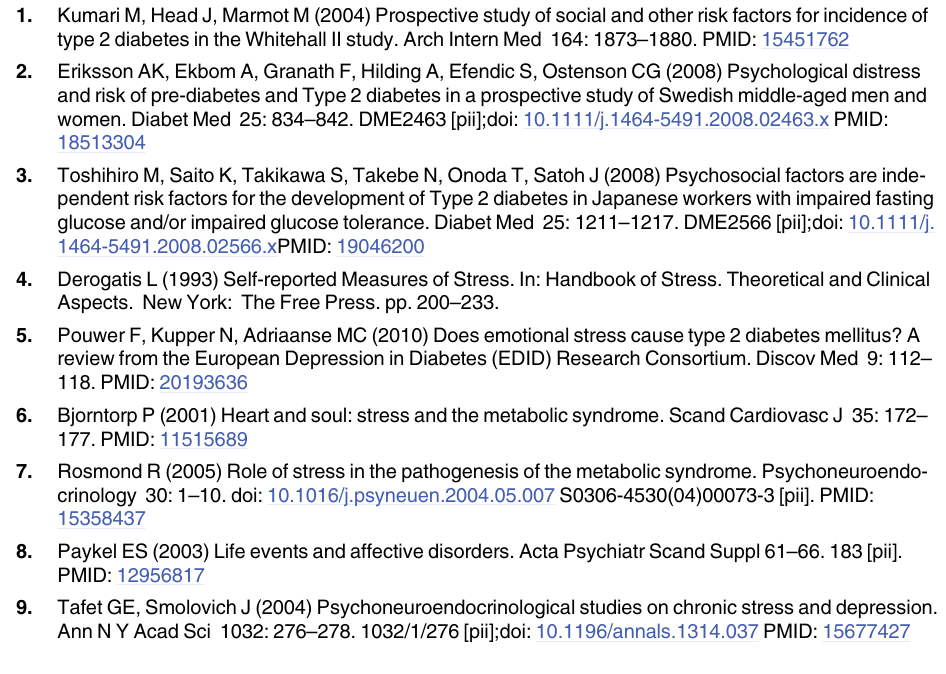
S1 Fig. Simplified causal diagram for relation between major life events and type 2 diabetes mellitus. S1 Table. Risk of incident type 2 diabetes mellitus (T2DM) by individual major life events in childhood, adult life and work life. Odds ratio (OR) are adjusted for age, sex, education and family history of